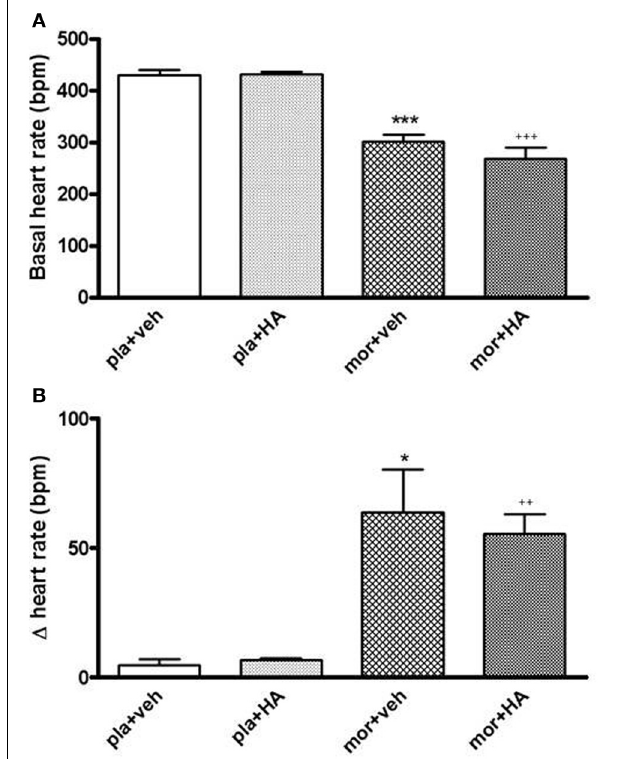
FIGURE 10 | Baseline heart rate(HR,beats per minute, bpm) in ratswith morphine (mor) or placebo (pla) pellets implantation concomitantly with vehicle (veh) or HA-1004 (HA), just before naloxone injection (A). Changes in HR 20min after naloxone (2mg/kg, s.c.) injection, in rats pre-treated with mor or pla concomitantly with veh or HA (B) . Data are the mean ± s.e.m. ( n = 4–6). ∗ p < 0 . 05, ∗∗∗ p < 0 . 001 vs. pla + veh; ++ p < 0 . 01, +++ p < 0 . 001 vs. pla +